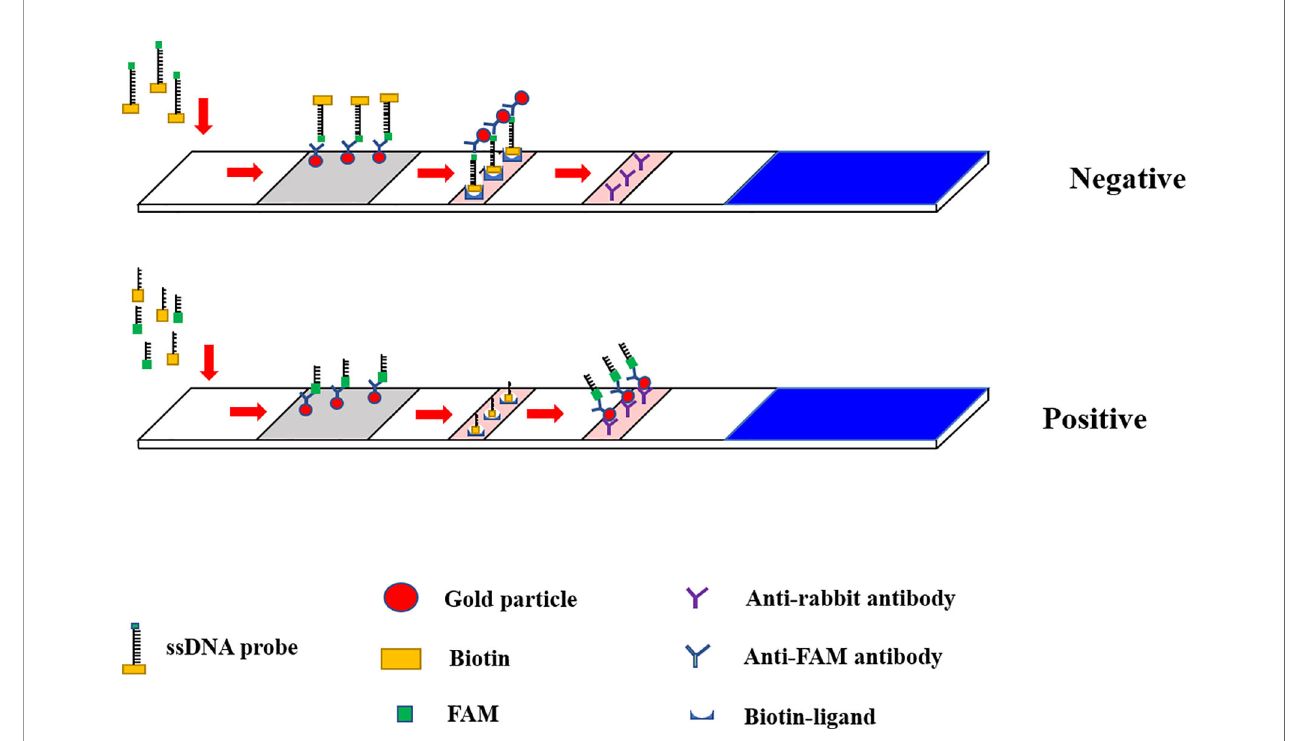
FIGURE 4 | Schematic diagram of Lateral fl ow dipstick